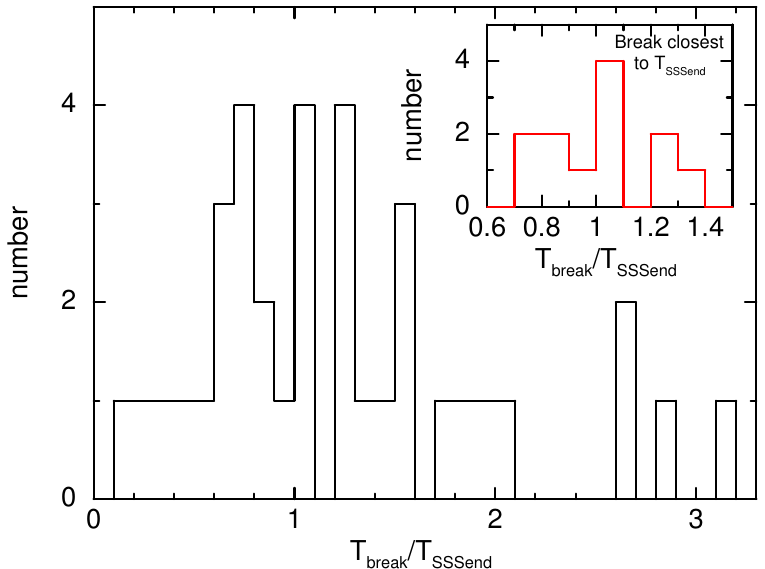
Figure 15. A histogram showing the normalised break times fitted in the UVOT light-curves for all novae in the sample; the best-sampled light-curve has been used in each case where observations were performed in more than one filter. The inset plots only the break for each nova light-curve which is closest in time to T break /T SSSend =